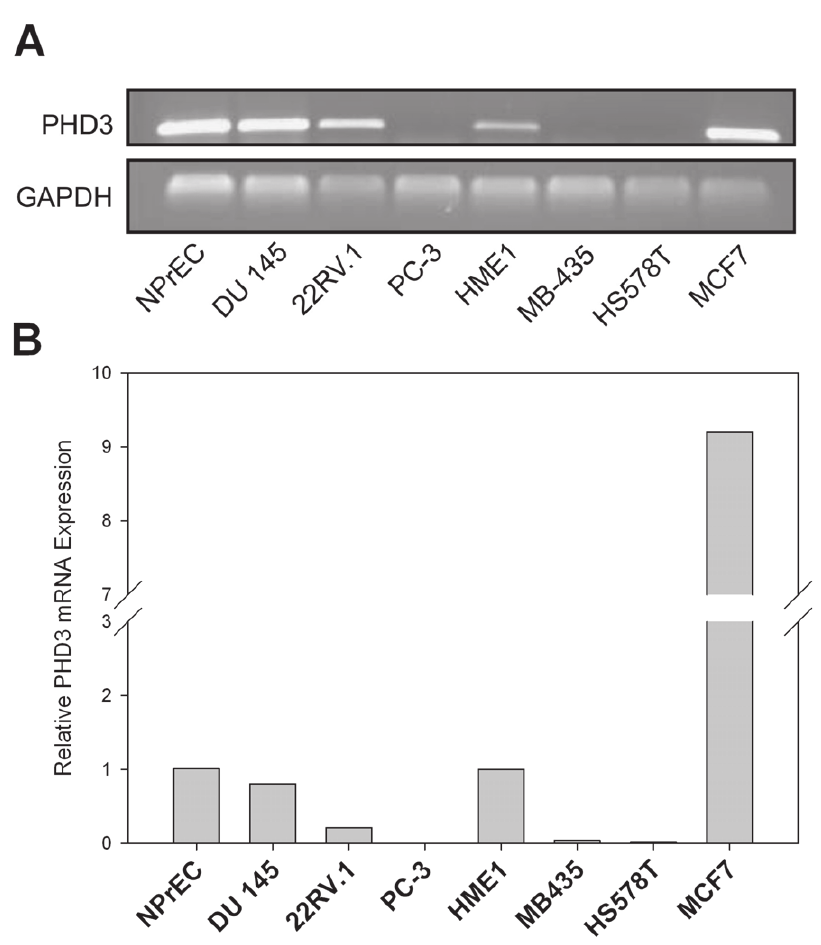
Figure 1. Differential expression of PHD3 mRNA in normal and tumor cell lines of prostate, breast and melanoma origin. Total RNA was extracted from the indicated cell lines. A ) Expression of mRNA was determined by semiquantitative RT-PCR using specific primers designed to amplify PHD3 and GAPDH. The RT-PCR products were electrophoresed using 1% agarose gel, with ethidium bromide to show bands of expected sizes. GAPDH was used as the loading control. B ) Quantitative real-time reverse transcription-PCR analysis of PHD3 was performed with normalization to 18S rRNA gene expression and relative quantities were determined by the DDCt method. The data shown are the PHD3 gene expression of individual cancer cell lines relative to those of their corresponding normal counterparts (PrEC for prostate and HMEC-hTERT for mammary).